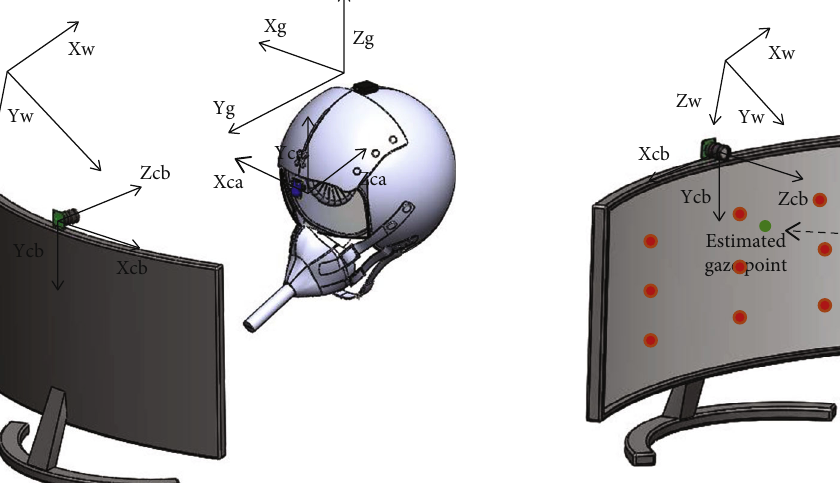
Figure 6: System